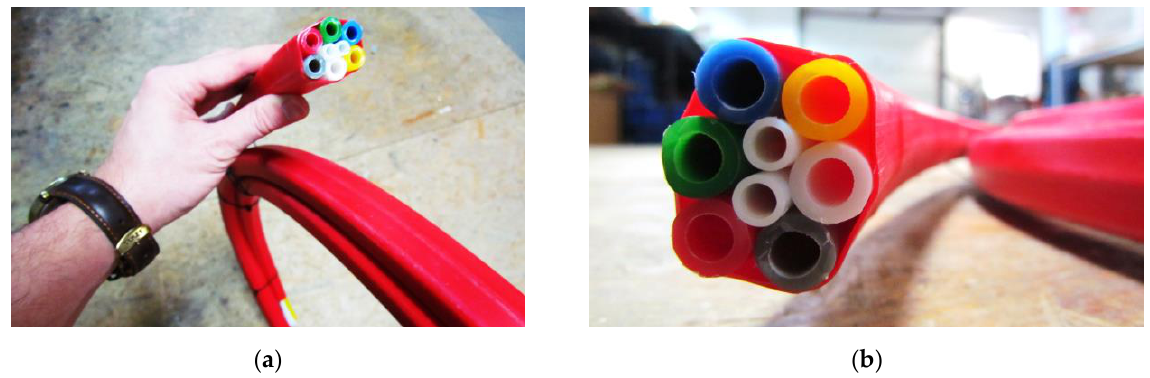
Figure 6. Prototype version of new hydraulic sensor SHM Profiler: ( a ) general view; ( b ) close-up to the cross section.